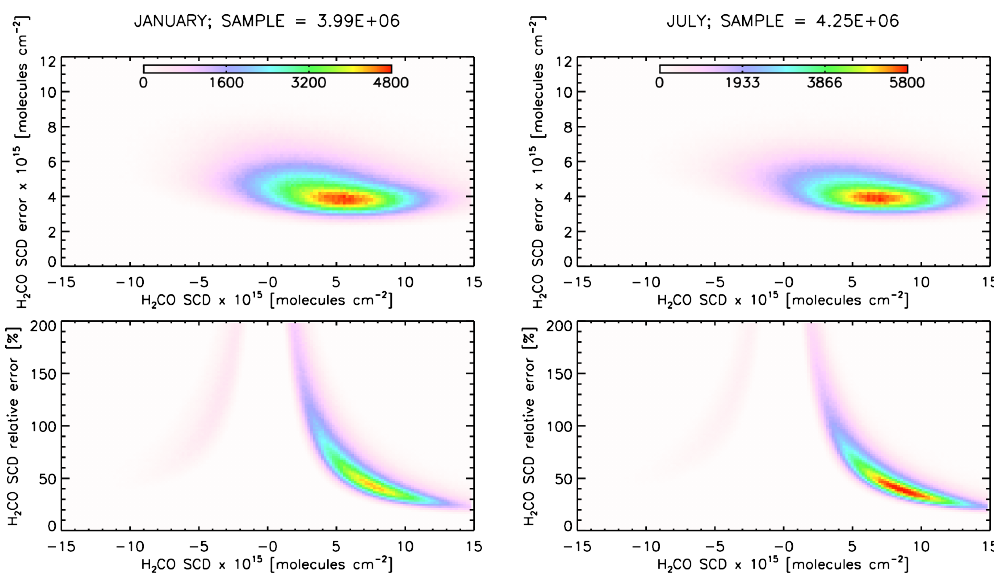
Figure 5. Absolute (top panels) and relative (bottom panels) error density probability functions vs. retrieved slant column for January (left panels) and July (right panels). Only pixels with SZA smaller than 70 ◦ have been considered in the calculation of the DPFs.